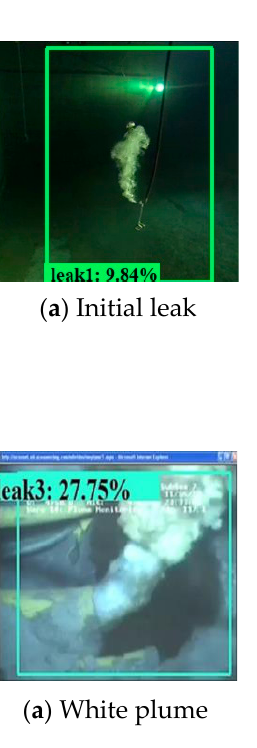
Figure 19. Visualization examples of the Faster R-CNN model developed under the image size 1280 × 720 dataset under the BP dataset.